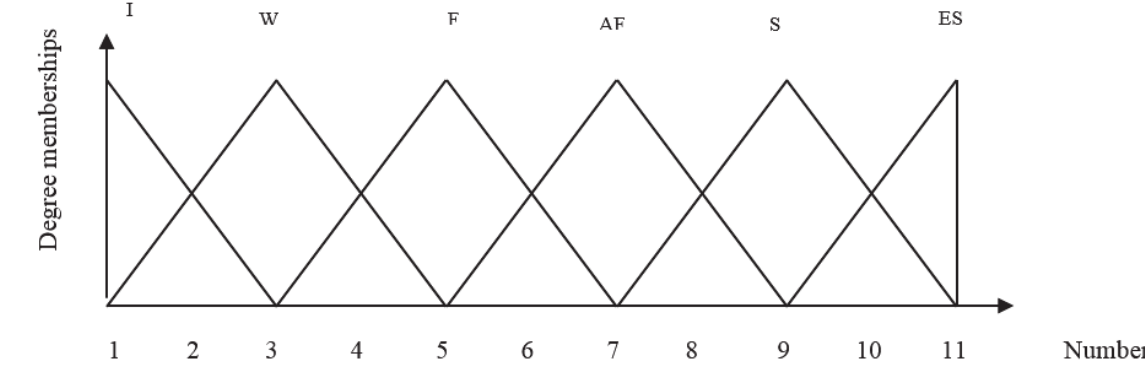
Fig. 5. Linguistic Terms in Weighting